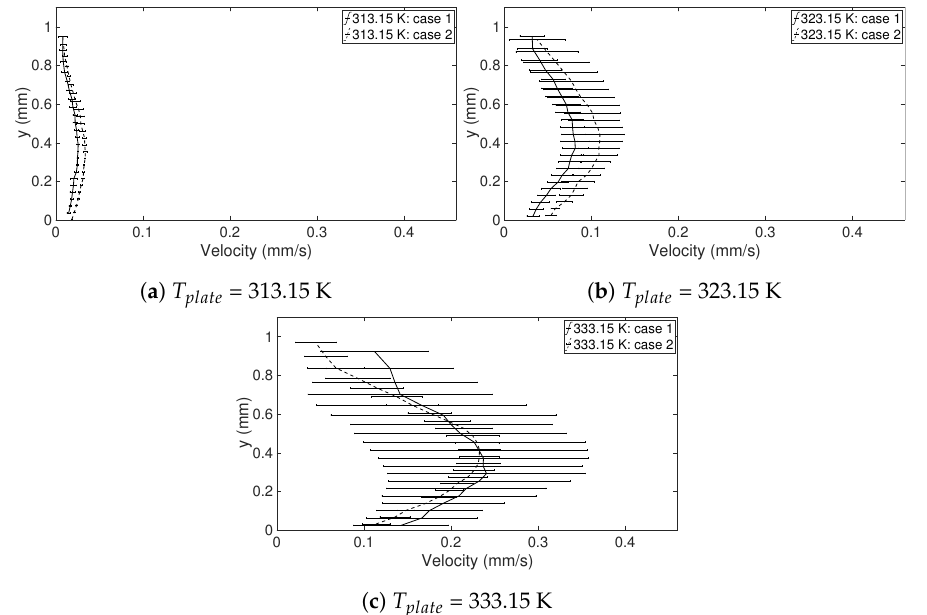
Figure 10. The spread (standard deviation) in velocity along the symmetry line during evaporation for T plate = 313.15, 323.15, and 333.15 K (all cases) when t = 20–50 s shown using error bars. The solid line is the mean velocity of all